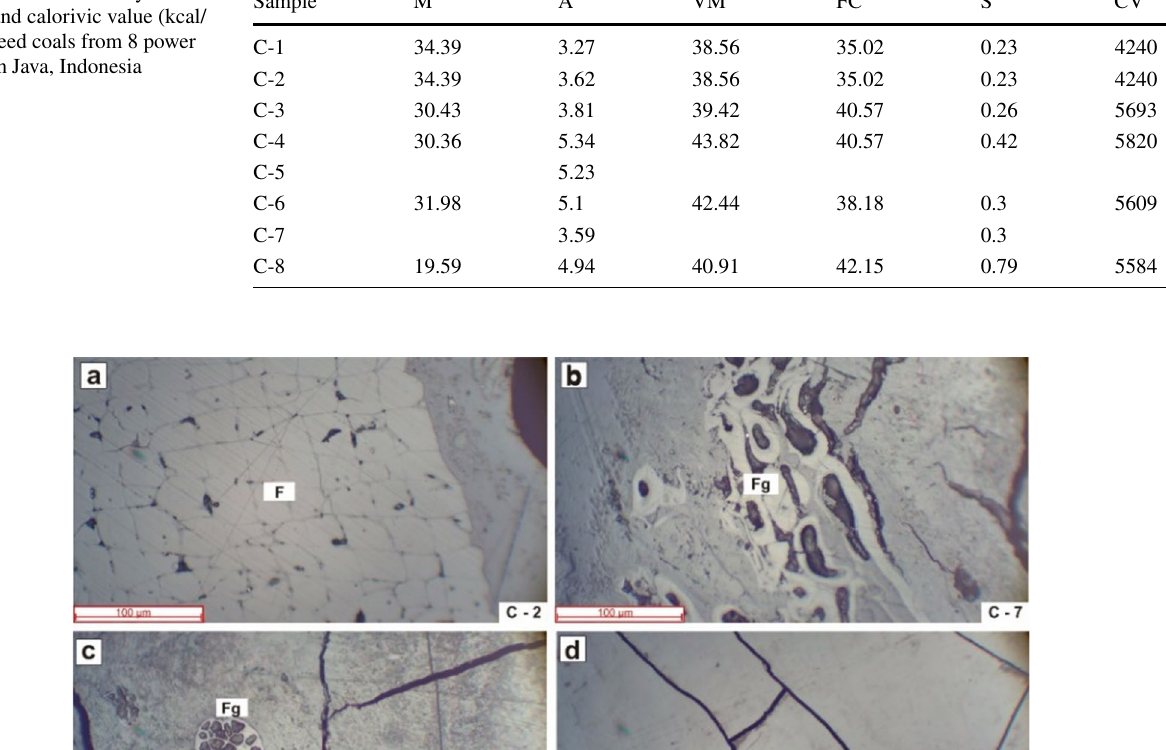
Table 2 Proximate analyses (wt%) and calorivic value (kcal/ kg) of feed coals from 8 power plants in Java, Indonesia